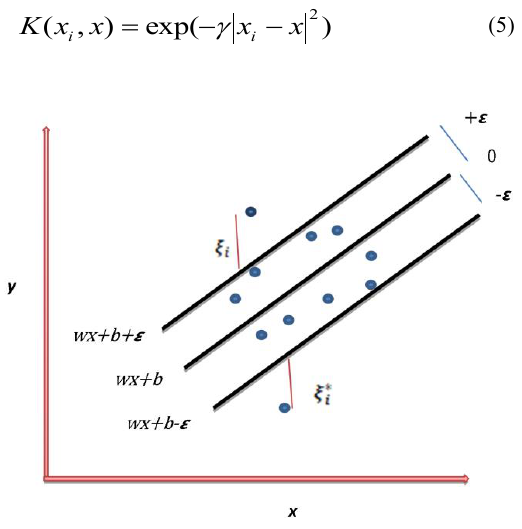
Figure 3.SVR formulation to minimize the cost function.